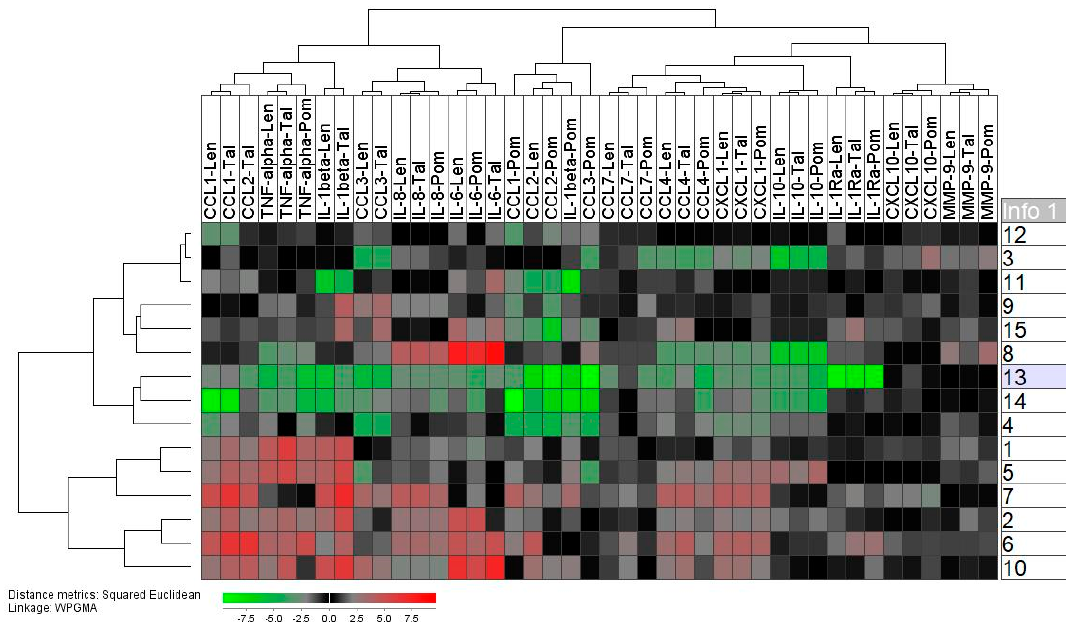
Figure 5. The effects of IMiDs on TLR4/LPS-stimulated cytokine release by normal monocytes; a hierarchical clustering analysis of the overall IMiD effects. The analysis was based on the relative mediator level, i.e., level in IMiD-containing LPS cultures relative to the level in the corresponding LPS stimulated IMiD-free control. Before the clustering analysis all relative responses for each mediator were normalized to the median relative response for all three IMiDs, i.e., they were normalized to the median relative response of all 45 IMID responses for each mediator (3 IMiDs, 15 individuals). Thus, green color thus means a relatively strong inhibitory effect. It can be seen that even for mediators showing highly significant effects of IMiDs there was a considerable variation among individuals with regard to the effects of IMiDs .